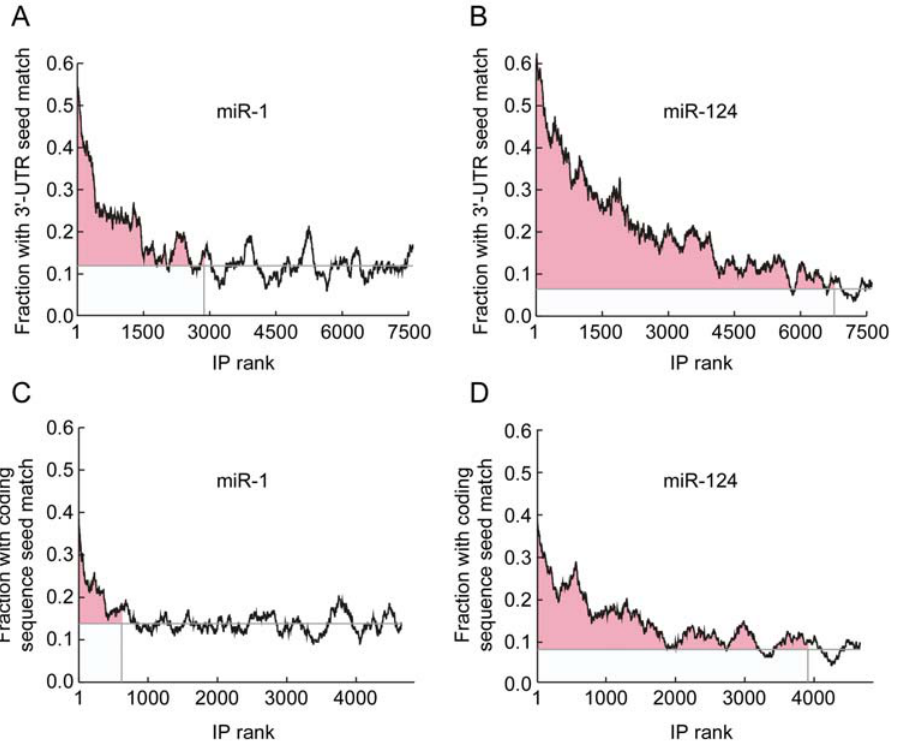
Figure 7. Estimation of the number of miR-1 and miR-124 targets. (A) Moving average plot (window size of 200) of the fraction of mRNAs with 7mer 3 9 -UTR seed matches to miR-1. mRNAs were ranked by their SAM enrichment in Ago2 IPs in the presence of miR-1 compared to Ago2 alone, with 1 corresponding to the most enriched mRNA. To determine the point at which the curve first rose above the background level of 7mer seed matches, we first calculated the slope of each least-squares-fit regression line between the right-hand end of the distribution and every point to left of it. The point at which the curve first rose above the background level of 7mer seed matches was determined as the point at which the slope was first negative (vertical grey line). The fraction of mRNAs containing 7mer seed matches to the right of the vertical grey line was considered to be the background level of 7mer seed matches (horizontal grey line). To estimate the total number of targets (pink shaded region), the number of mRNAs to the left of the vertical grey line (3071 of 7805) was multiplied by the fraction of mRNAs to the left of the vertical line containing 7mer 3 9 - UTR seed matches (0.23) minus the fraction of mRNAs to the right of the vertical line containing 7mer seed matches (0.12). This results in an estimate of 325 targets. (B) Same as in (A), but for miR-124. 6393 of 7817 mRNAs were to the left of the vertical grey line. The fraction of mRNAs with 7mer 3 9 - UTR seed matches to the left of the grey vertical line was 0.21, while the fraction of mRNAs with 7mer seed matches to the right of the grey vertical lines was 0.07. This results in an estimate of 1000 targets. (C) Same as in (A), except moving average plots of the fraction of mRNAs with 7mer coding sequence seed matches to miR-1. mRNAs with 6mer 3 9 -UTR seed matches were removed, leaving 4855 mRNAs. 820 mRNAs were to the left of the vertical grey line. The fraction of mRNAs with 7mer seed matches to the left and right of the grey vertical line was 0.24 and 0.14 respectively. This results in an estimate of 83 targets. (D) Same as in (C), but for miR-124. 3312 of 3916 mRNAs were to the left of the vertical grey line. The fraction of mRNAs with 7mer seed matches to the left and right of the grey vertical line was 0.15 and 0.08 respectively. This results in an estimate of 236